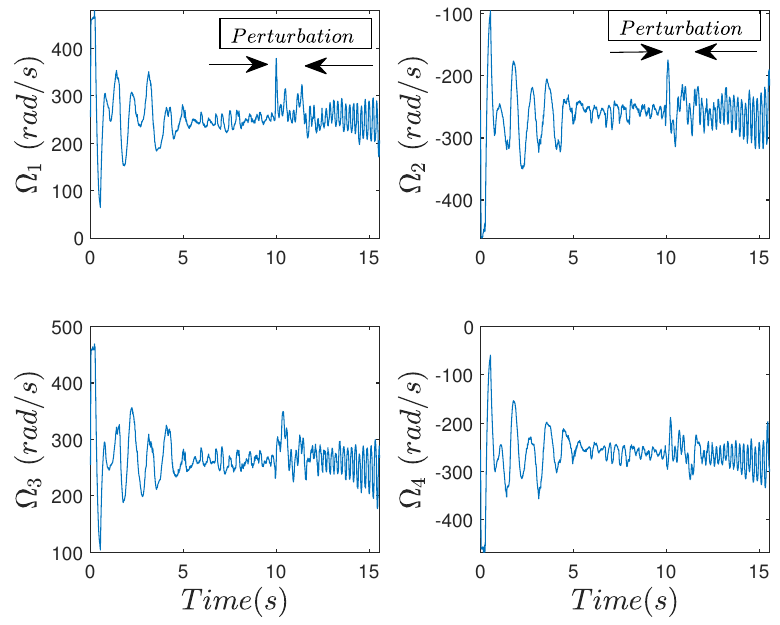
Figure 10. Hovering. Control inputs of the quadrotor MAV under external perturbations.